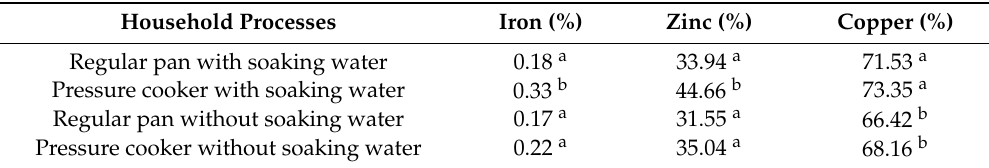
Table 3. Bioaccessibility levels (%) of iron, zinc and copper in black bean cooked with traditional household